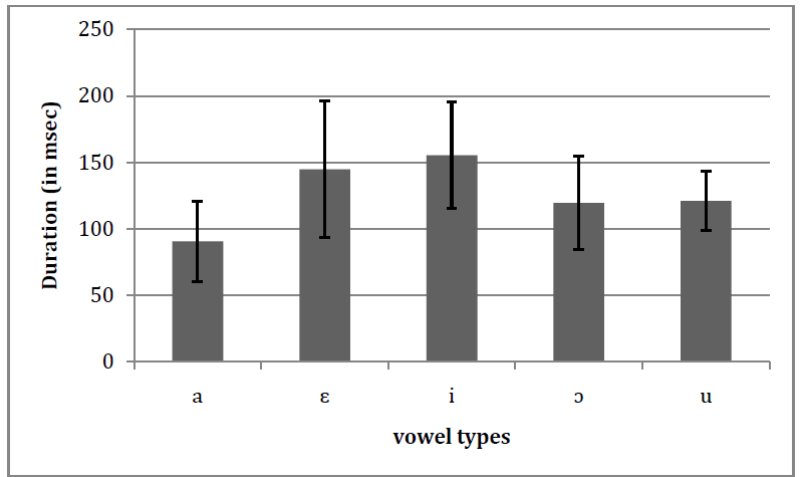
Figure 2: Average duration of Deori vowels with standard deviation as error bars